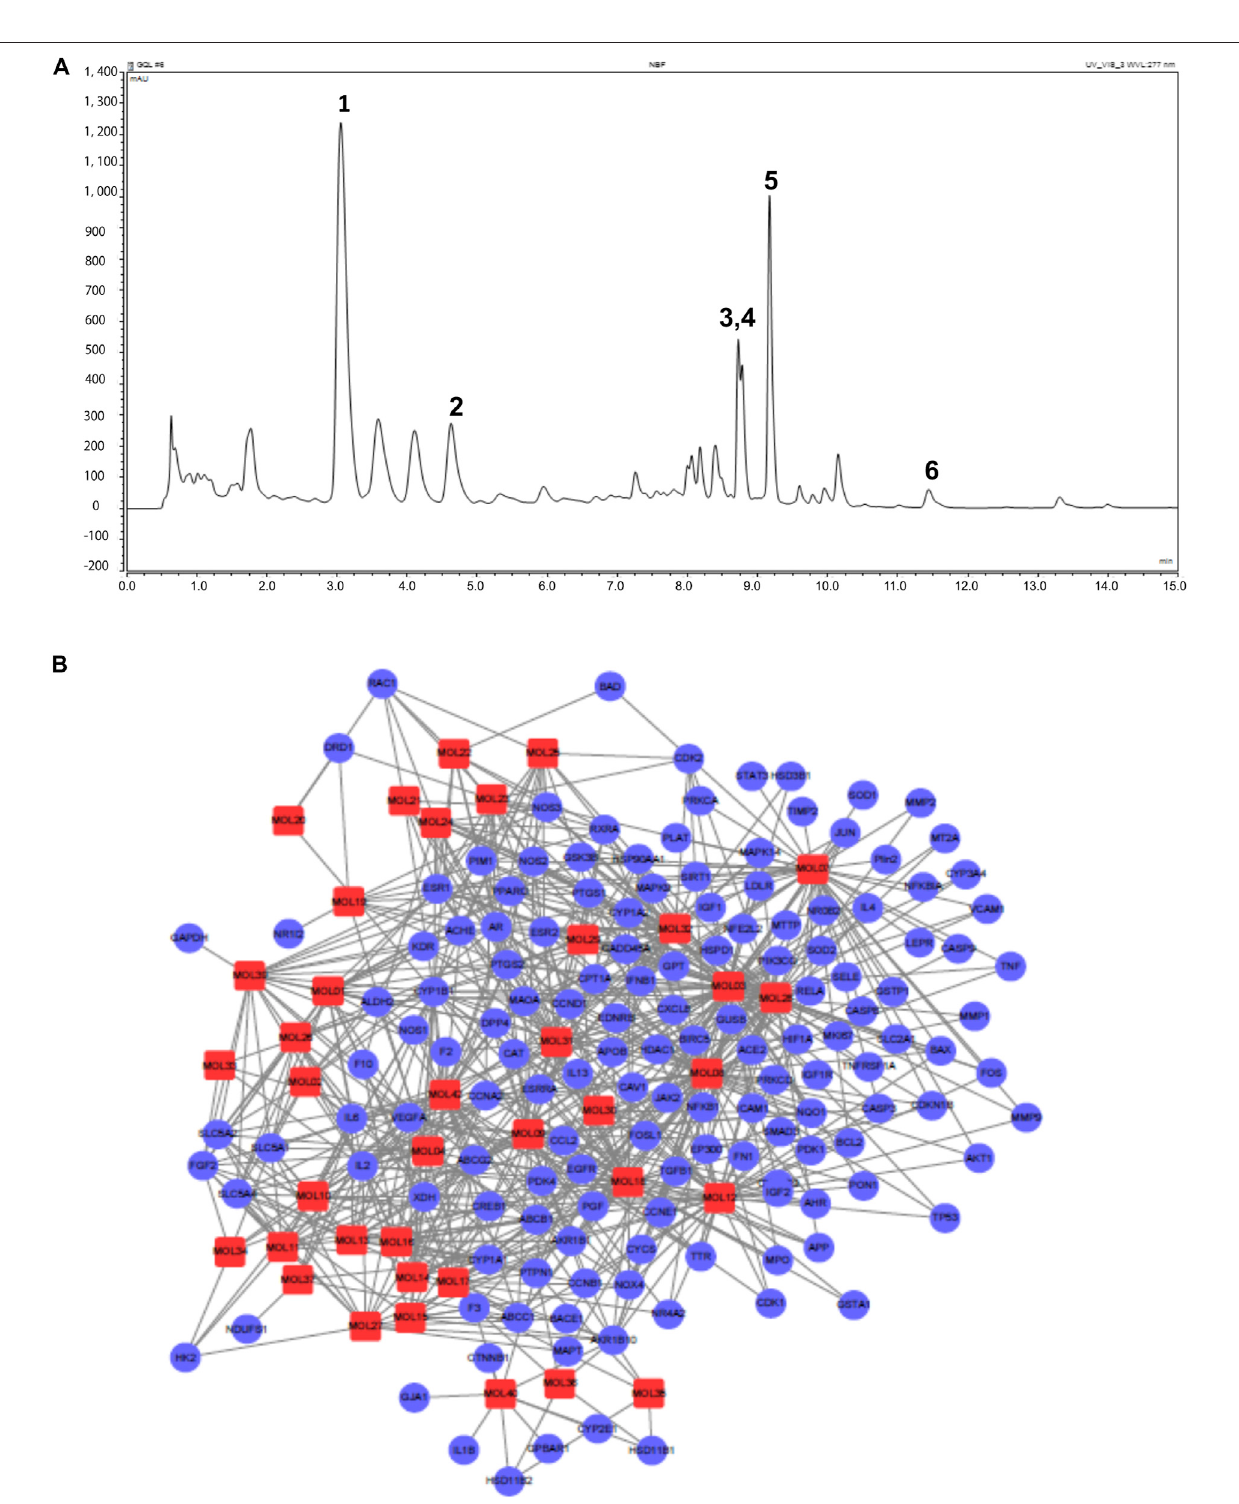
FIGURE 1 | (A) UPLC-UV pro fi les of GQL. (1) Puerarin (MOL07), (2) daidzin (MOL01), (3) berberine (MOL24), (4) palmitane (MOL25), (5) baicalin (MOL17), and (6) baicalein (MOL12). (B) Compound – target network with 715 edges and 186 nodes. Red squares indicate antidiabetic active compounds (13) of GQL. Purple circles indicate 80 common target proteins of active GQL constituents and T2DM targets. Edges indicate interactions between targets and ingredients.